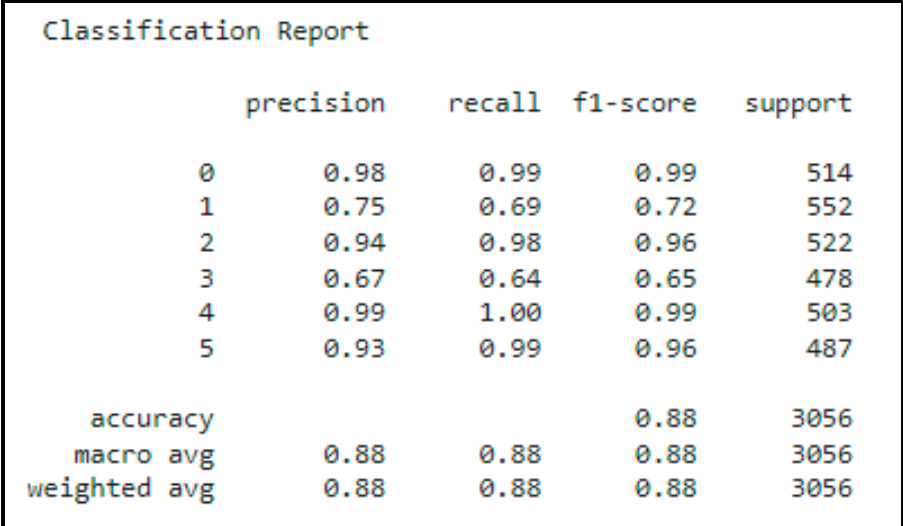
Figure 16. Classification Report of Naive Bayes.